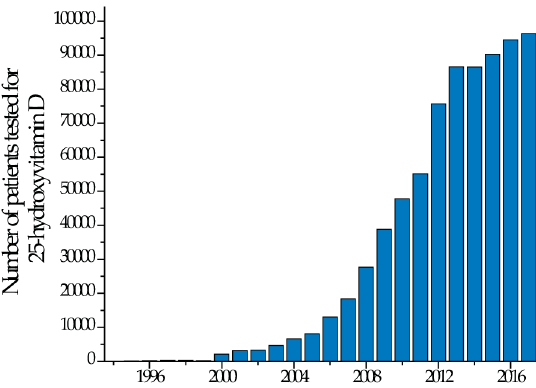
Figure 1. Sustained increase in testing volumes of vitamin D at the Mayo Clinic.